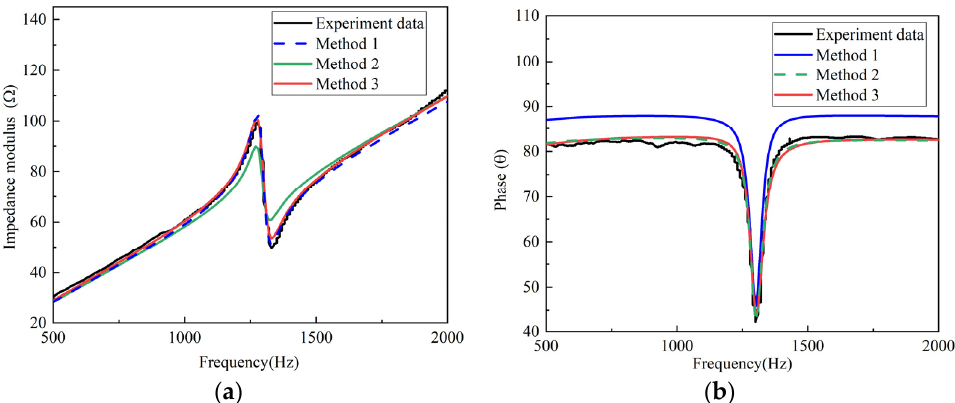
Figure 13. Comparison of the experimental data and simulation data under pre-stress conditions of 10 Mpa ( a ) impedance modulus and ( b ) phase.